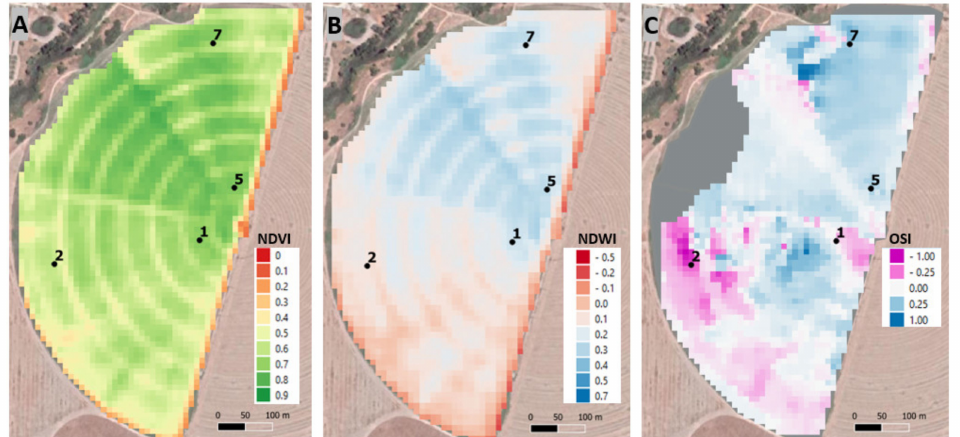
Figure 10. Maps of the NDVI ( A ), the NDWI ( B ), and the OSI ( C ) for 12 September 2021. The gray pixels in the OSI map represent a cloud shadow in the 7 September 2021 image, which was used to prepare the 12 September